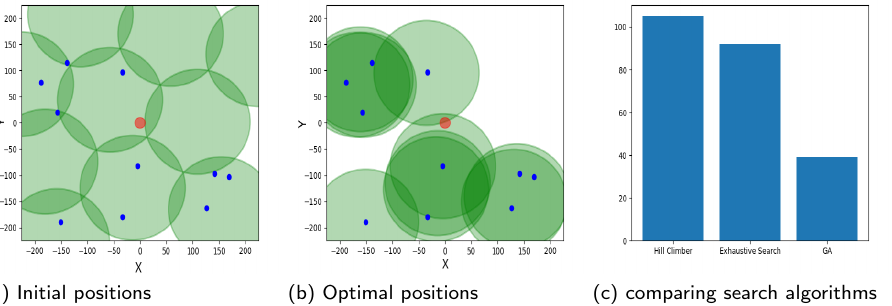
Figure 6. UAV deployment within an AOI with 10 users (blue dots). ( a ) shows initial UAV positions covering the area, ( b ) shows the final UAV positions focusing on user locations and bandwidth sharing, and ( c ) compares the three search